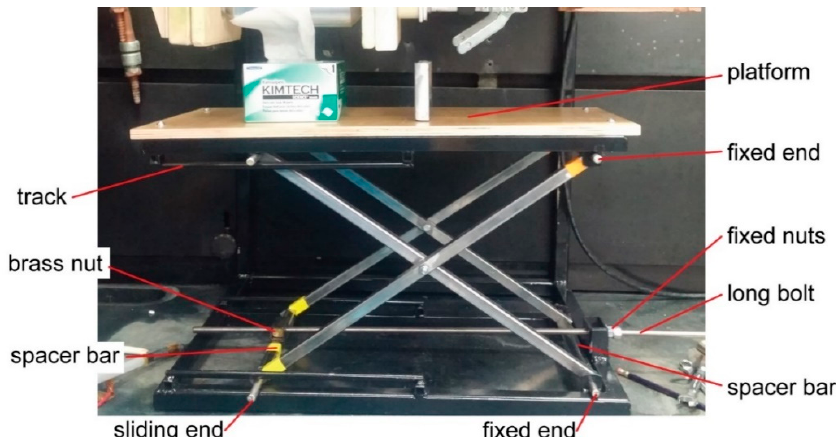
Figure A5. The scissors stand we constructed for our electrospinner as assembled on the steel frame. Note that the photograph is not of the final version, and so the long bolt does not yet have a socket wrench attached, cotter pins are not pictured, and the pictured wooden platform was not used in the final electrospinner design. The orange and yellow objects in the picture are unimportant pieces of tape wrapped around the legs or spacer bar. Scale can be interpreted from the box of Kimtech kimwipes or the pencil (right side bottom).